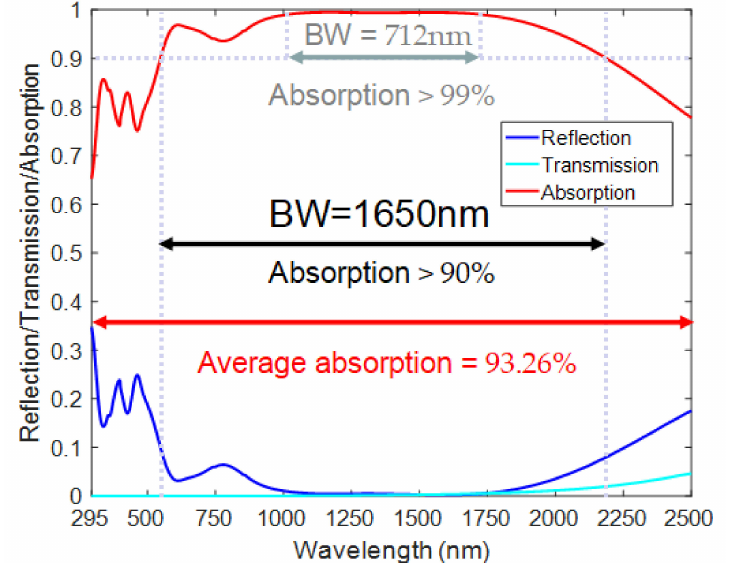
Figure 2. Normalized reflection, transmission, and absorption spectrum under normal incident light. The thickness of the four layers of SiO 2 –Ti–SiO 2 –Ti, respectively are a = 150 nm, h 1 = 60 nm, h 2 = 70 nm, and h 3 = 150 nm. The elliptical nanodisk has a long-axis length of D = 340 nm and a short-axis length of d = 120 nm. The length in the x and y directions is P = 400